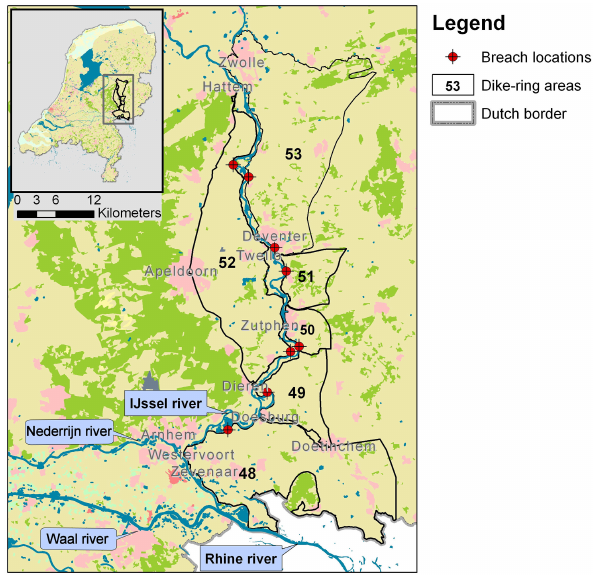
Figure 1. Case study area: IJssel River valley with delineation of dike-ring